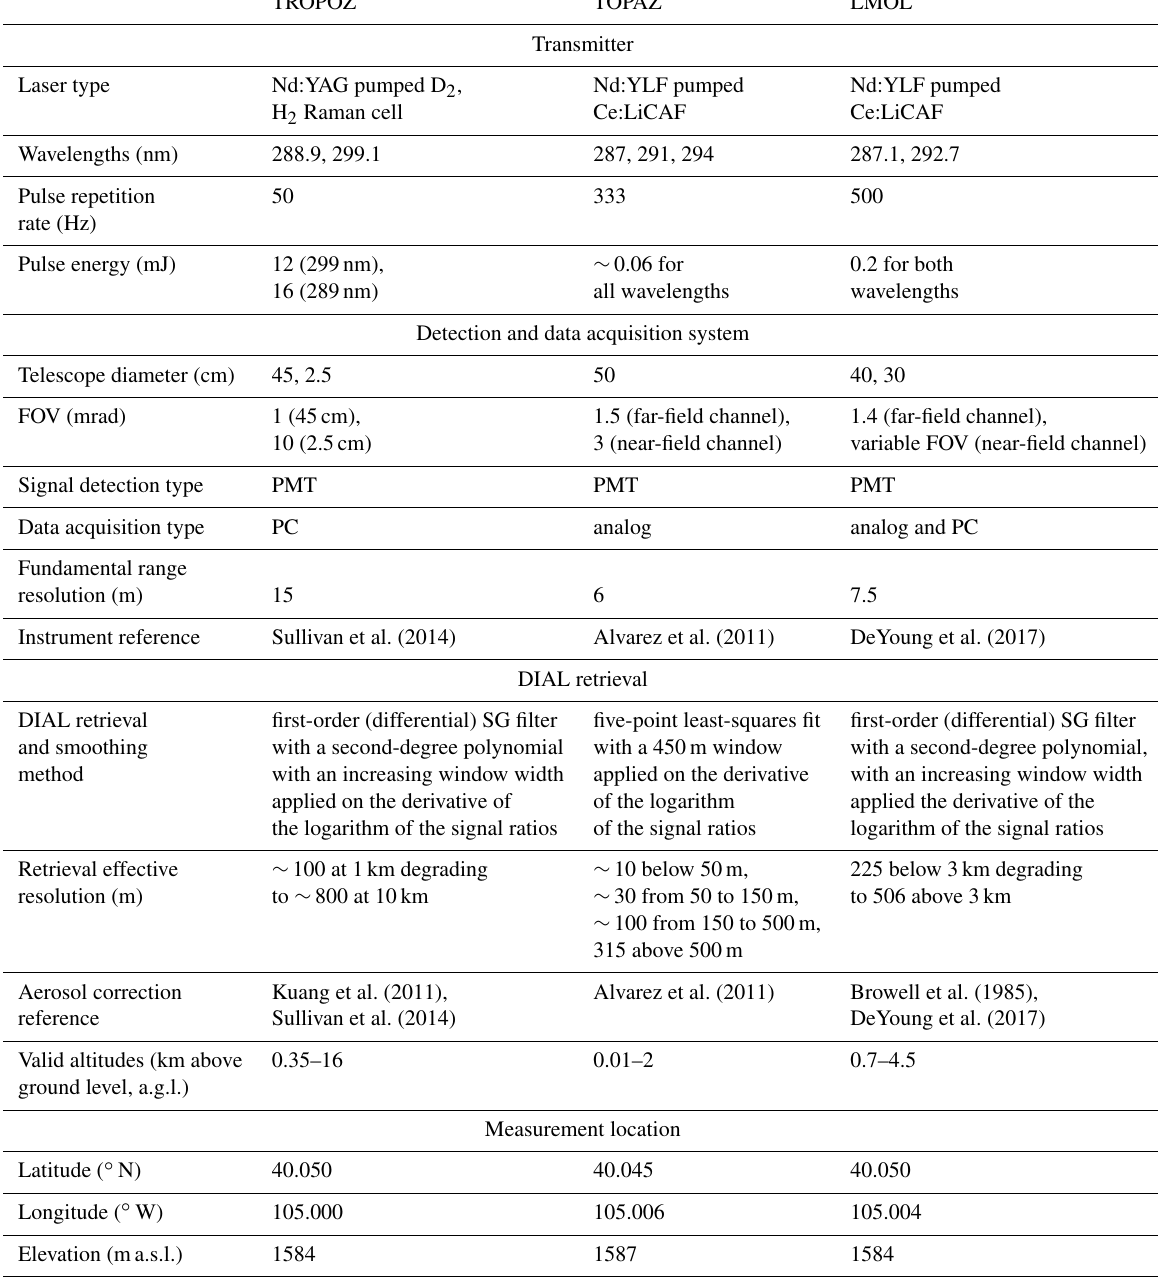
Table 1. Specifications for the TOLNet